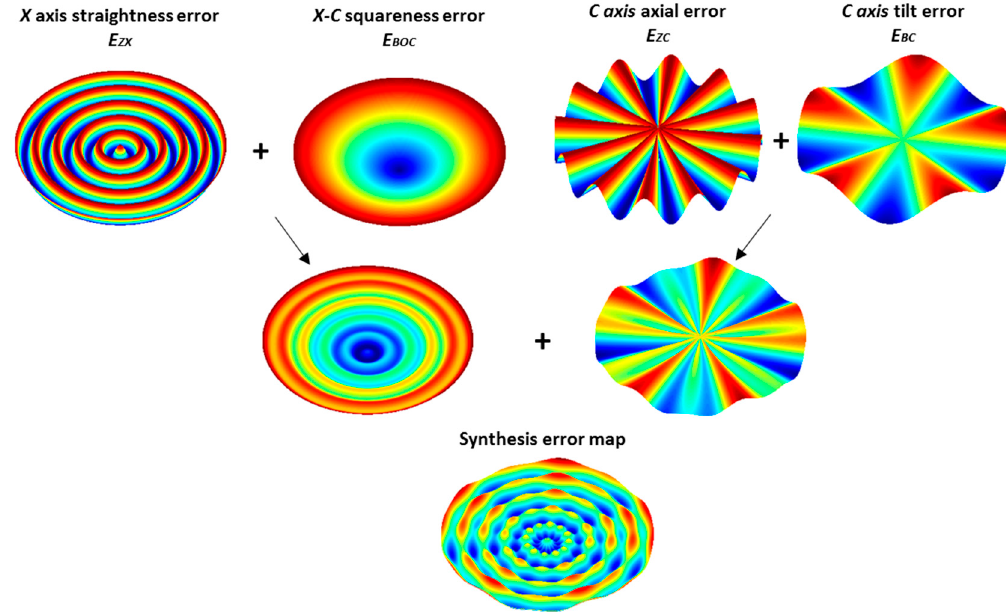
Figure 5. Simulation of the kinematics error effect on the OMSM results.